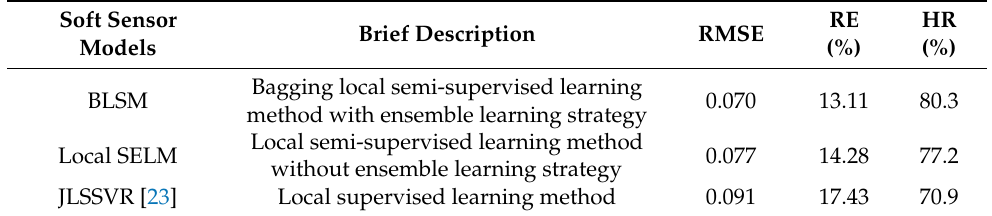
Table 1. Detailed prediction performance comparison of semi-supervised and supervised learning models (best results are bold and